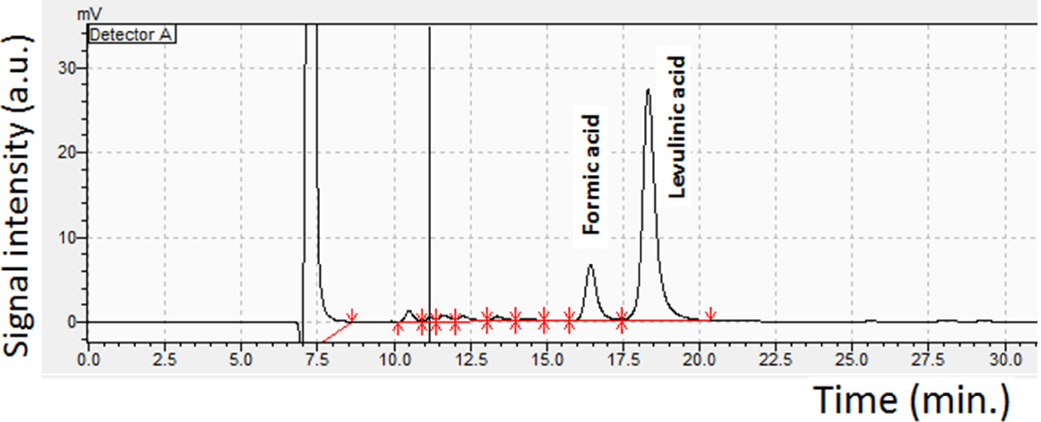
Figure A2. HPLC analysis of liquid product.